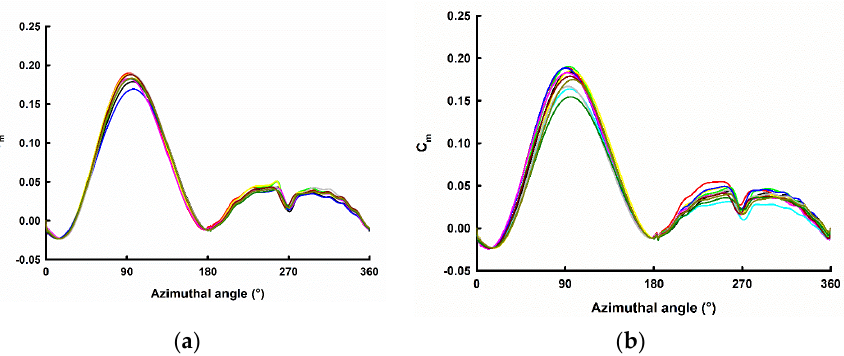
Figure 7. Moment coefficient for various rotational cycles. ( a ) Randomised Fluctuation = 2 m/s; ( b ) Randomised Fluctuation = 6 m/s. Coefficient of Moment at various time instances (rotational cycles) are represented through different coloured lines. Due to randomized wind conditions, values vary every rotational cycle.